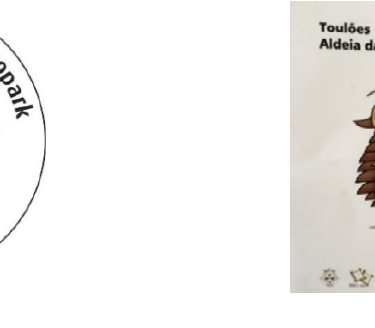
Figure 12. Naturtejo UGGp: ( a ) The mascot and promotion ambassador for the ( b ) Peony Festival. The logo of Naturtejo UGGP comprises an abstract rendering of typical geological and natural features of the geopark.